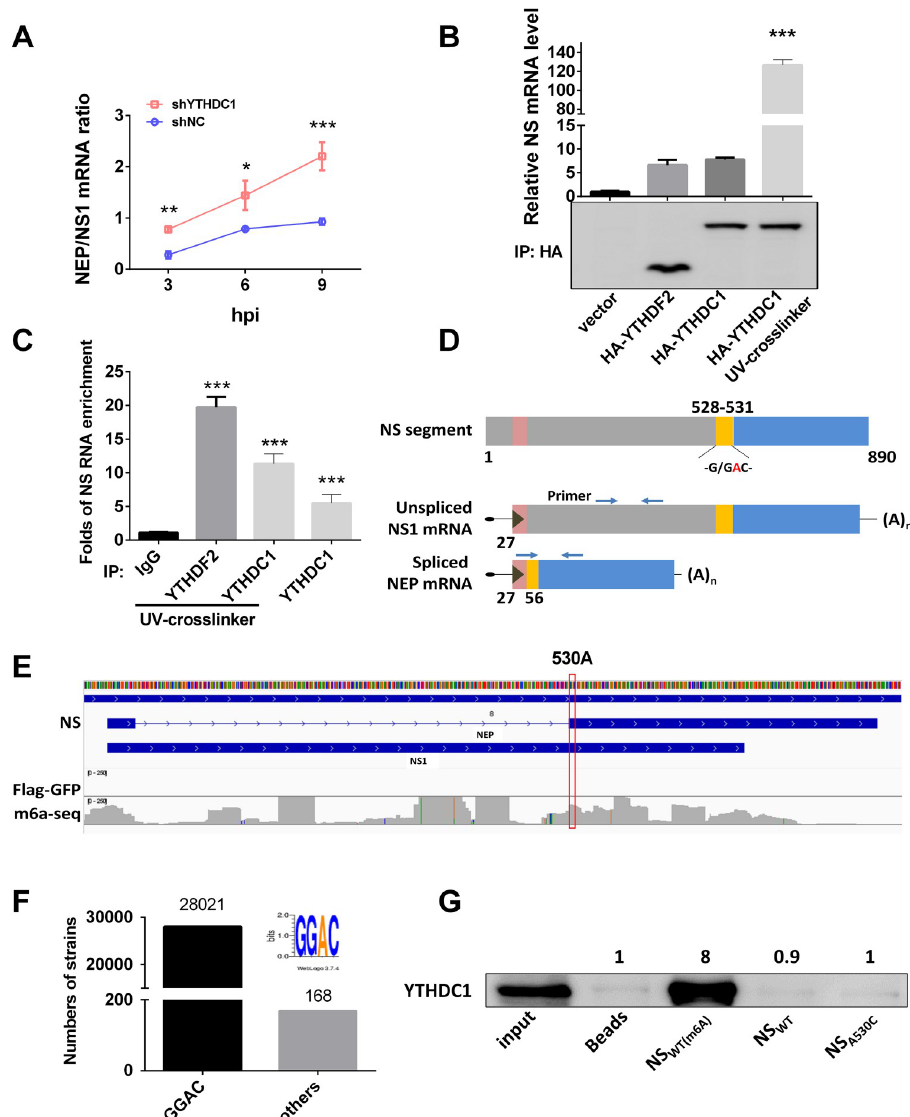
Fig 3. NS1 inhibits NS segment splicing by YTHDC1. (A) YTHDC1 knockdown (shYTHDC1) or negative control (shNC) knockdown A549 cells were infected with the PR8 virus at an MOI of 5. The ratios of NEP to NS1 mRNA were calculated at indicated time points with the specific primers. Data are presented as the average of three experiments and error bars indicate the standard error of the mean (SEM) (two-way ANOVA test; * P < 0.05, ** P < 0.01; *** , P < 0.001). (B) HEK293T cells were transfected with indicated plasmids for 24 h and then infected with the PR8 virus at an MOI of 1 for 12 h. RIPs and RT-qPCR were performed using specific primers detecting viral NS mRNA. Fold enrichment of mRNA was calculated. Data are presented as the average of three experiments and error bars indicate the standard error of the mean (SEM) (one-way ANOVA; *** , P < 0.001). (C) A549 cells were infected with the PR8 virus at an MOI of 1 for 12 h. RIPs and RT-qPCR were performed using specific primers detecting viral NS mRNA. Fold enrichment of mRNA was calculated. Data are presented as the average of three experiments and error bars indicate the standard error of the mean (SEM) (one-way ANOVA; *** , P < 0.001). (D) NS1 mRNA and its alternatively spliced product were depicted, and the arrowheads show primer positions for detection of various. G/GAC (528–531) is the YTHDC1-binding site and ‘/’ is the 3 0 splicing site in the NS segment. (E) A view of the NS segment of IAV-PR8. PA-m 6 A-seq has a y-axis of 0–250 reads[14]. The 530A site is marked in the red box. (F) Analysis of GGAC motif in NS 528–531 segment of IAVs, total of 28189 strains were analyzed. (G) Pulldown YTHDC1 proteins using 20 bp NS biotin-probes of PR8: probes were immunoprecipitated with the cell lysis. And the bead eluate was analyzed by western